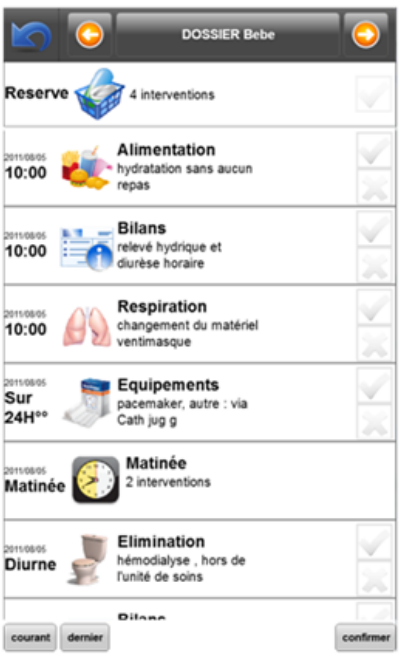
Figure 4. Intervention management interface on a computer screen in the HUG CIS and on the mobile device